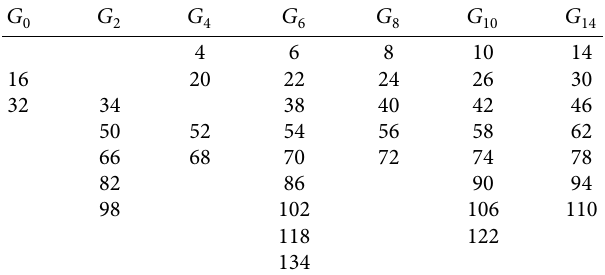
Table 3: The second Gourava index values which do not exist.